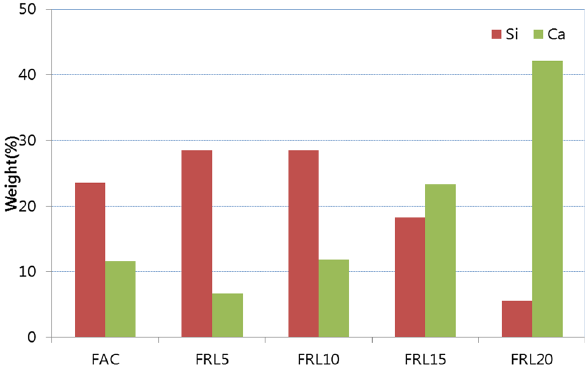
Fig. 10 EDS quantitative results for Si and Ca (weight